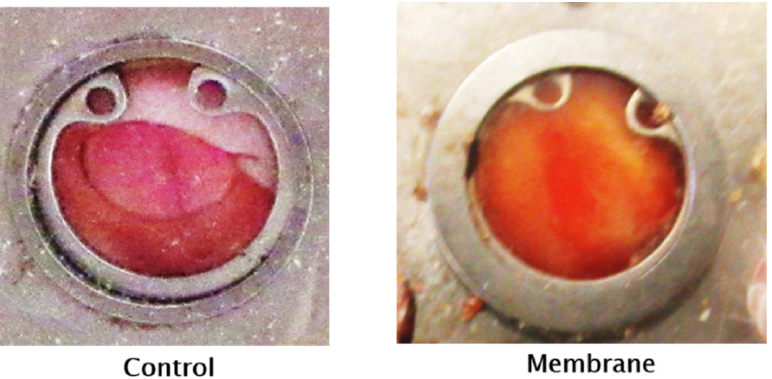
Figure 10. Representative photographs of the dorsal skinfold chamber model in the control and membrane groups on the 21st postoperative day.